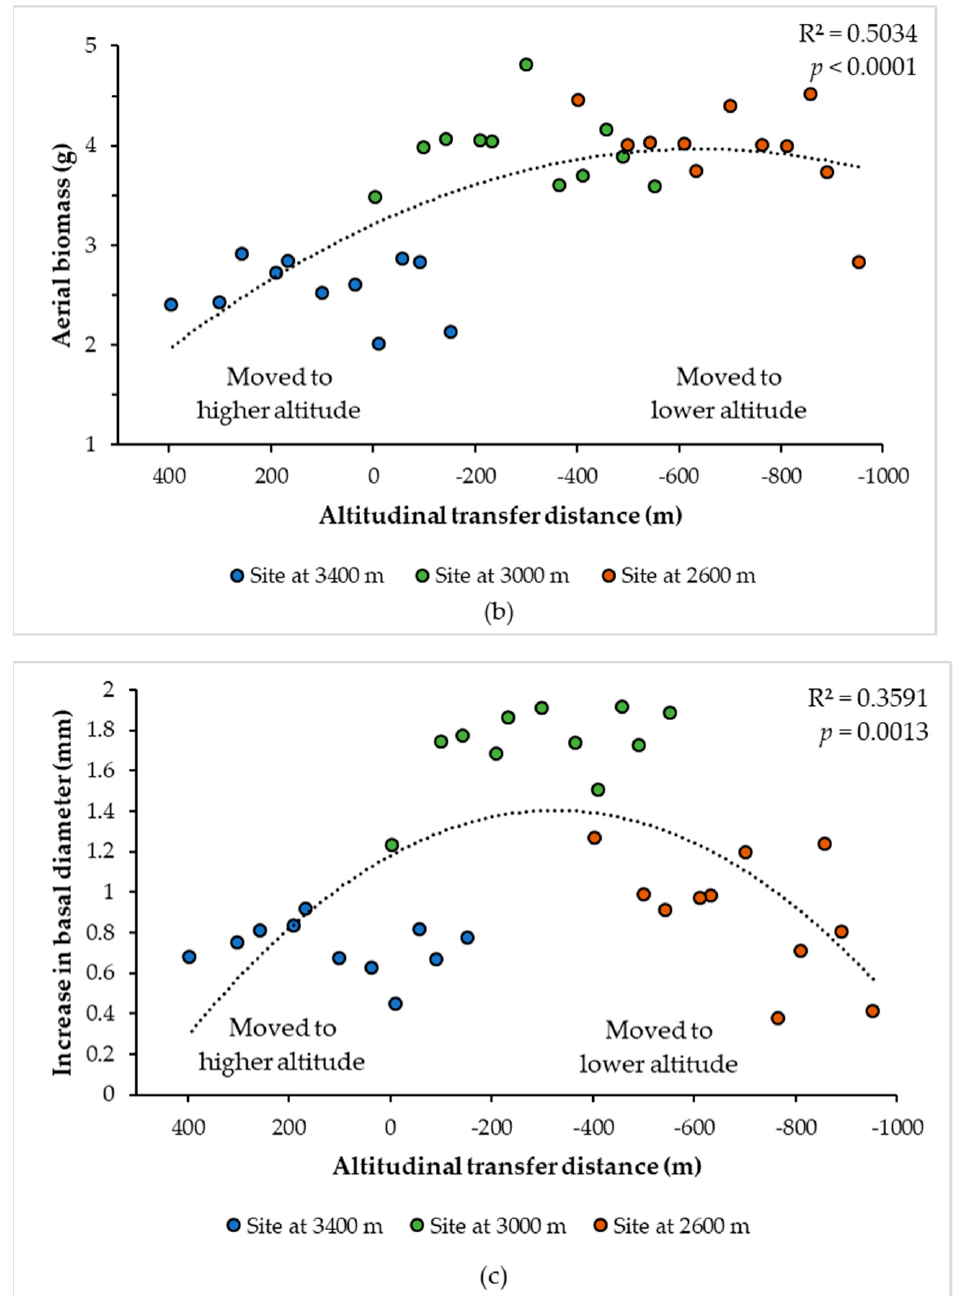
Figure 3. Estimated response curve (based on a quadratic regression) of the plants to the altitudinal transfer for: ( a ) survival; ( b ) aerial biomass (in dry weight); and ( c ) increase in basal diameter. Symbols indicate the average observed values per provenance per site. Symbol color denotes the particular assay site: blue, 3500 m a.s.l.; green, 3000 m a.s.l.; orange, 2600 m a.s.l. Positive values on the x -axis indicate movement towards sites of higher altitude, which are colder and moister, while negative values indicate movement towards sites of lower altitude, which are warmer and